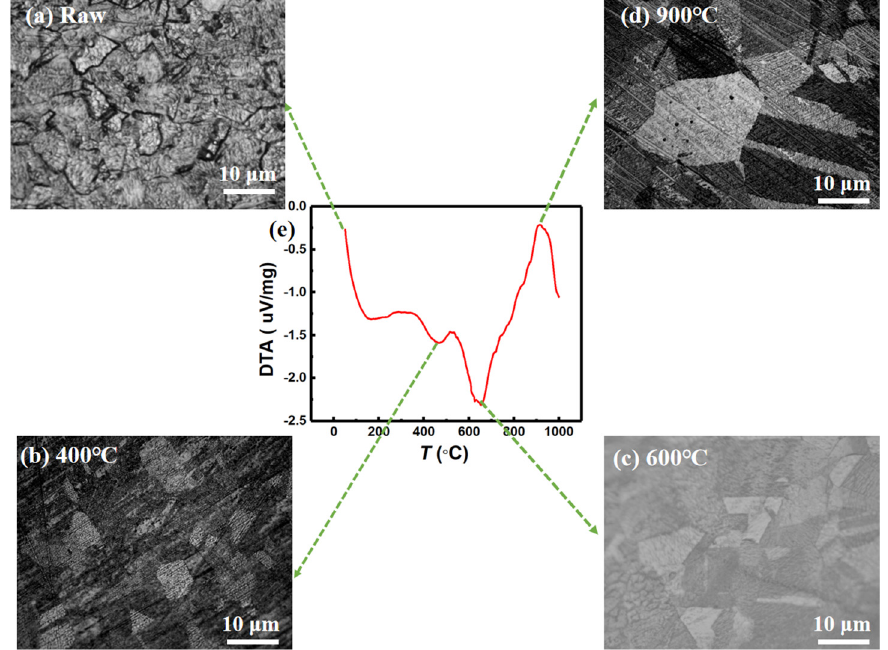
Figure 4. Micrograin structure of samples treated with different heat treatment processes: ( a ) raw, ( b ) 400 °C, ( c ) 600 °C, and ( d ) 900 °C. ( e ) Differential thermal analysis (DTA) as the function of temperature (range from 50 °C to 1000 °C).